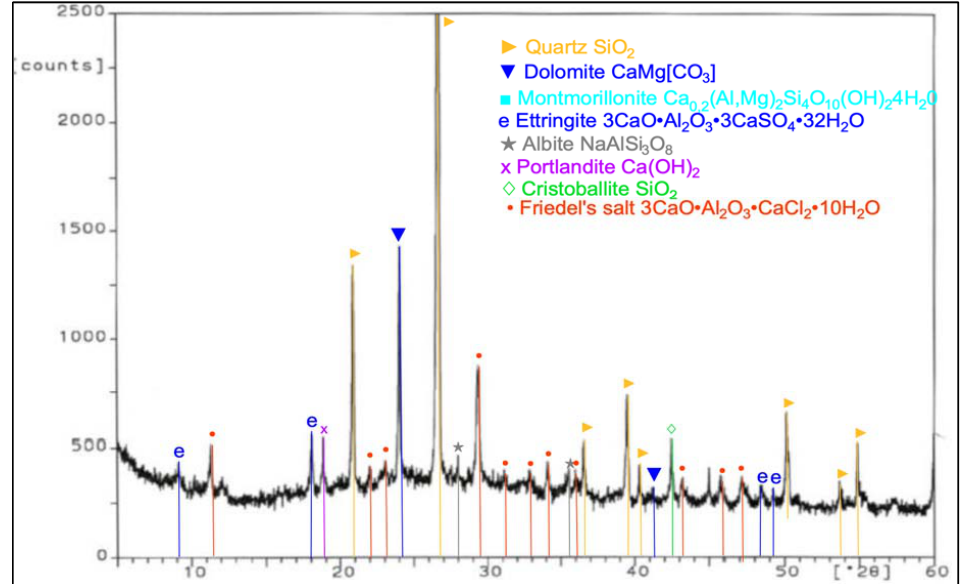
Figure 26. XRD pattern of the ZIII mortar (CEM I + 45% FBC) stored in 1% HCl for 730 days.